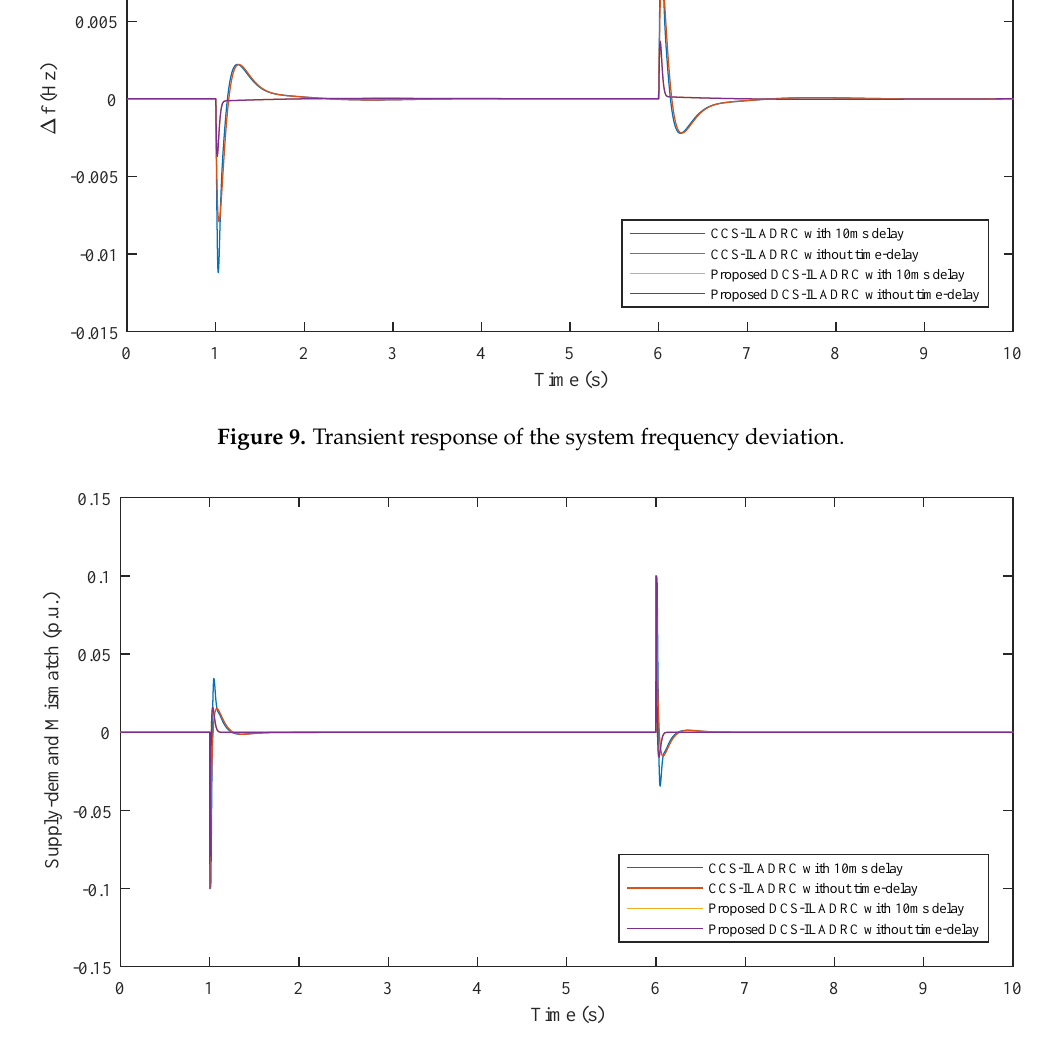
Figure 10. Transient response of supply-demand mismatch. Table 5. Performance comparison with CCS-ILADRC without time delay, CCS-ILADRC with 10-ms delay, DCS-ILADRC without time delay and DCS-ILADRC with 10-ms delay. Disturbance Control Strategy Overshoot Settling Time ITAE + RoCoF ∆ P L = 0.1 p.u.